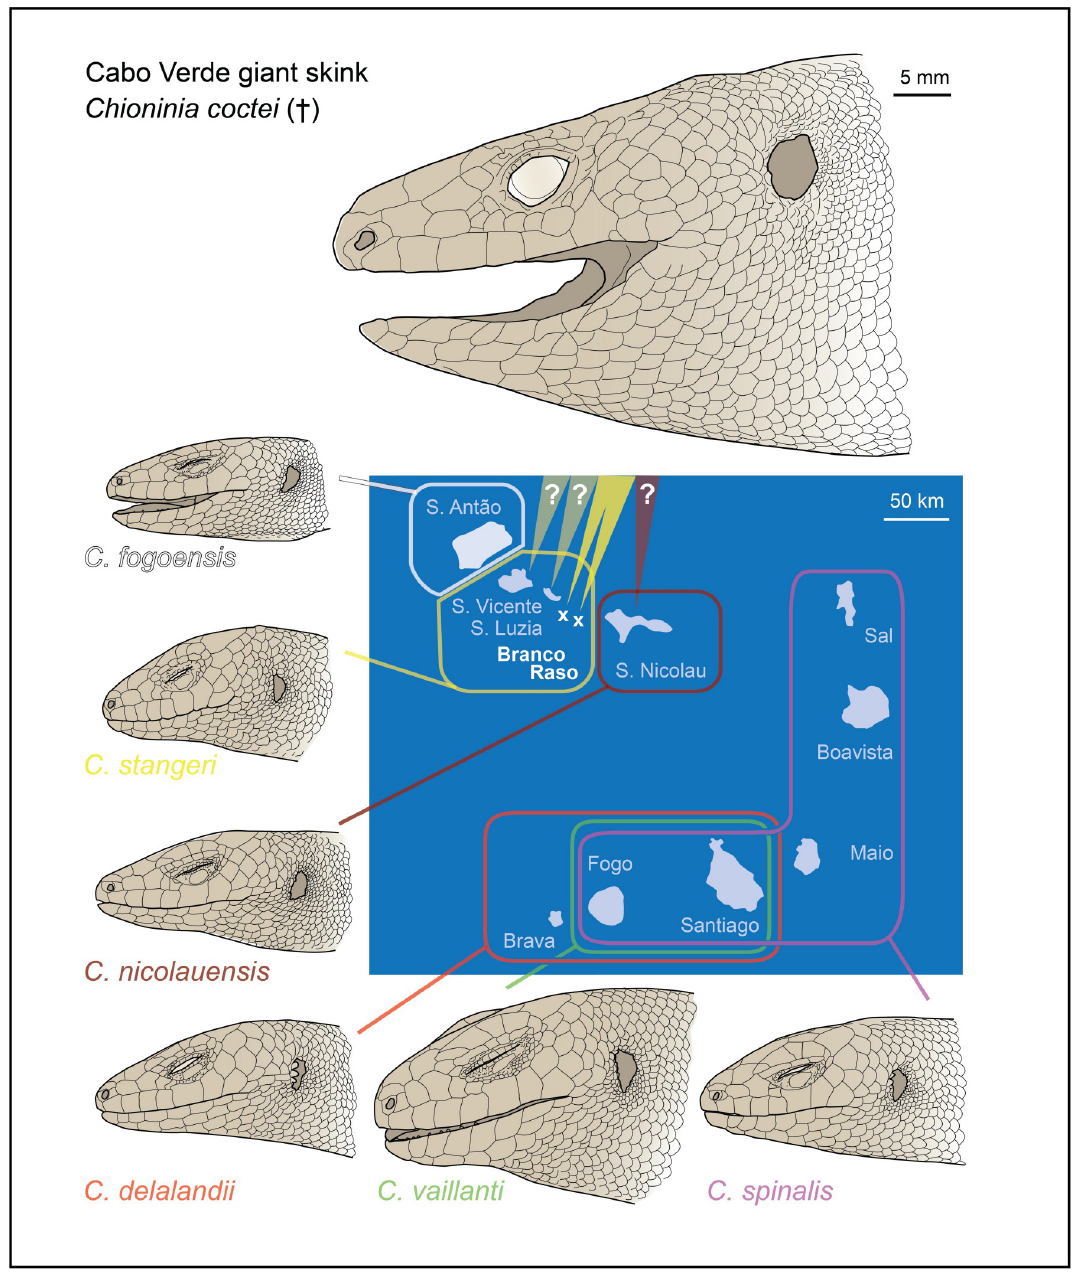
Fig 1. Extant and extinct (†) Chioninia species of Cabo Verde Islands. Distribution map of the seven different endemic Chioninia species, with illustrations showing their remarkable size variation.